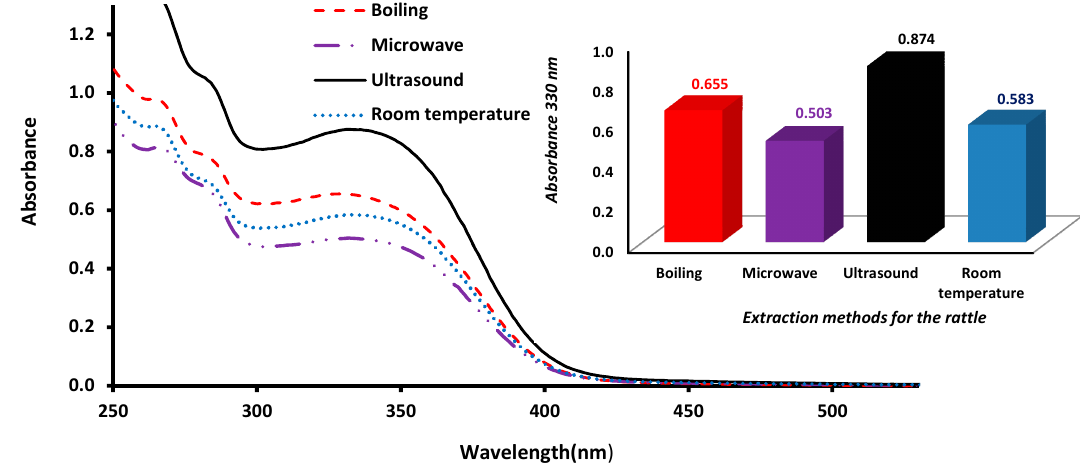
Figure 3. Evolution of absorption curves according to the wavelength and comparison of the absorption levels from λ max for the St. John’s Wort supernatants activated by the four conditions.